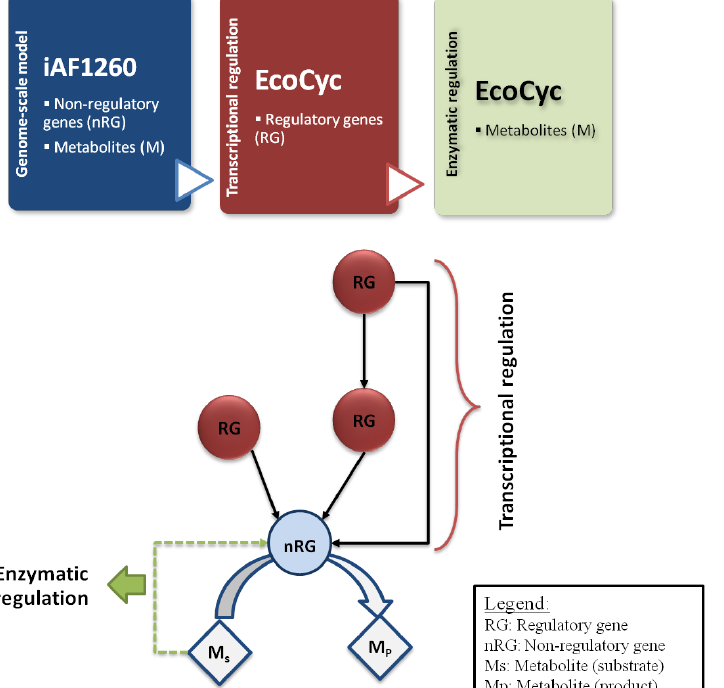
Figure 1: An integrated regulatory network for E. coli : combining the manually curated iAF1260 model with regulatory data from EcoCyc repository. Gene-reaction associations consisting on non-regulatory genes (nRGs), which code for enzymes that catalyse the conversion of metabolic substrates (Ms) into products (Mp), were obtained from the iAF1260 model. EcoCyc informa- tion on transcriptional and enzymatic regulation was further associated to non-regulatory genes (nRGs). All regulatory genes (RGs) that directly or indirectly affect the transcription of enzyme- coding genes were included in the integrated network. In the case of enzymatic regulation, all metabolites that affect the activity of an enzyme included in the metabolic model were associated with the respective enzyme-coding genes or non-regulatory genes (nRGs). In addition, metabolites that are not a substrate or a product in any reaction of the model were